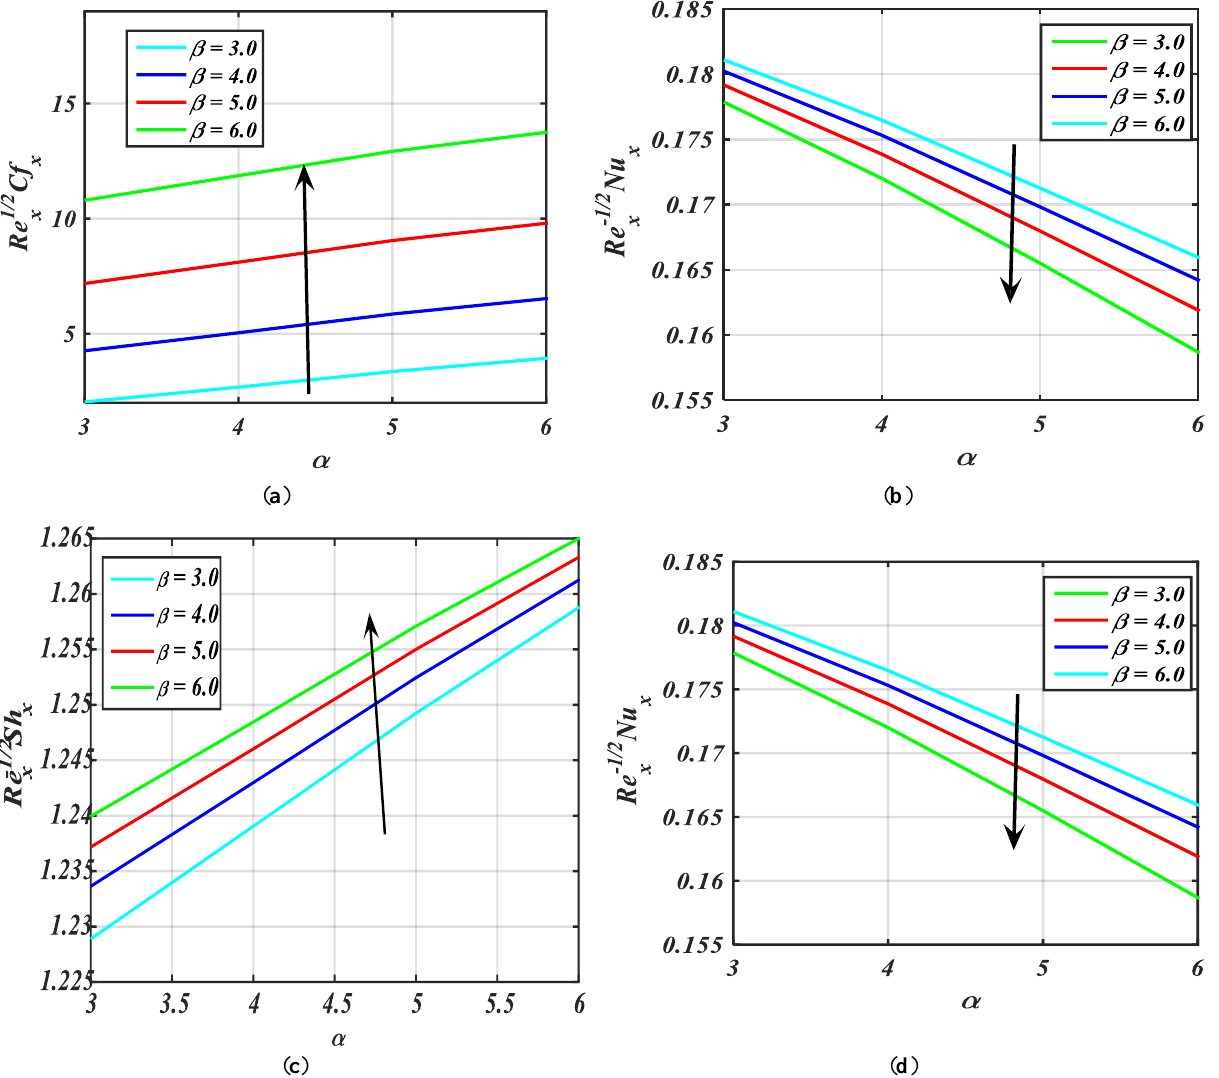
, 𝑅𝑒 𝑥−1/2 𝑁𝑢 , 𝑅𝑒 𝑥−1/2 𝑆ℎ , 𝑅𝑒 𝑥−1/2 𝑁ℎ 𝑥 𝑥 𝑥 against 𝛼 for diverse , Re − 1/2 x Nu x , Re − 1/2 x Sh x , Re − 1/2 x Nh x against α for diverse 𝑥 x